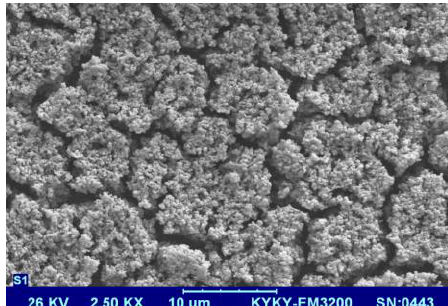
Figure 4. Nanocomposite ceramic coating with heat treatment at 450 ° C, at 2500 times